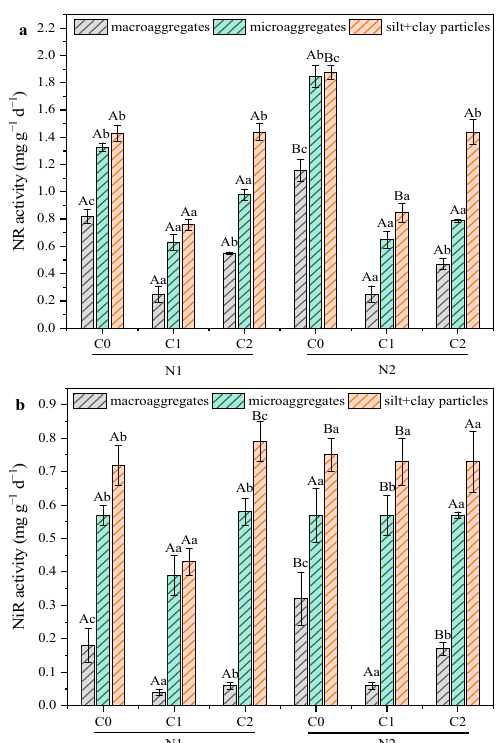
Figure 2. Change in the activity of NR ( a ) and NiR ( b ) in soil aggregate fractions. Macroaggregates (0.25–2.0 mm), microaggregates (0.053–0.25 mm), and silt+clay particles (<0.053 mm). The different lowercase letters indicate significant difference among straw input amounts of the same N application at p < 0.05. Different capital letters indicate a significant difference among N application amounts of the same straw input at p <